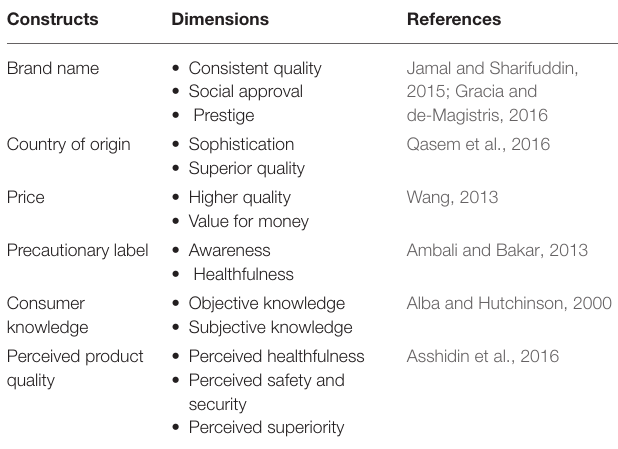
TABLE 1 | City wise sample size.